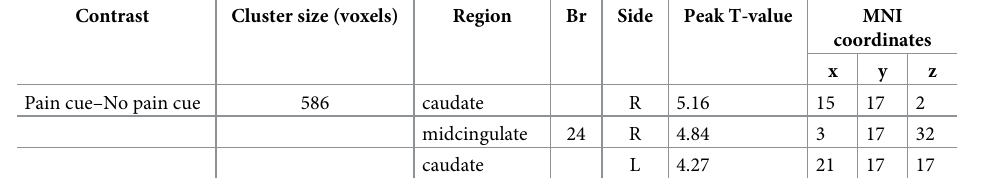
Table 5. Relationship between migraine frequency (average number of migraine attacks per month) and pain anticipation. Contrast Cluster size (voxels) Region Br Side Peak T-value MNI